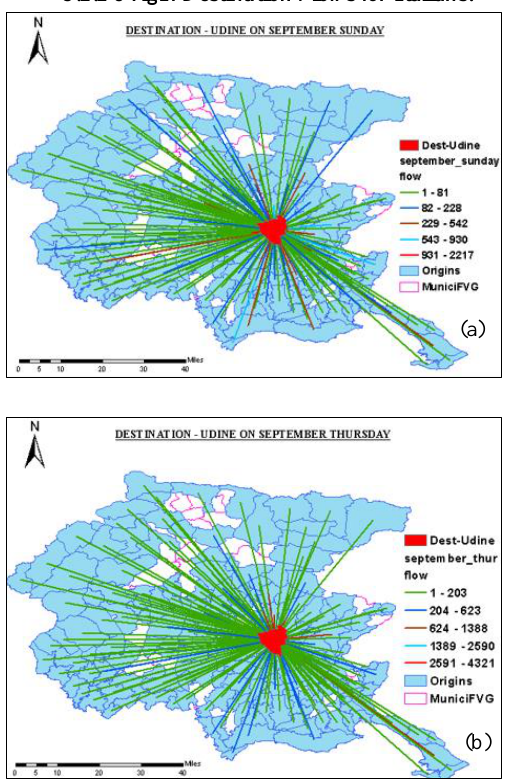
Figure 3.2.2-3 (a) & (b) OD flows of Italians on